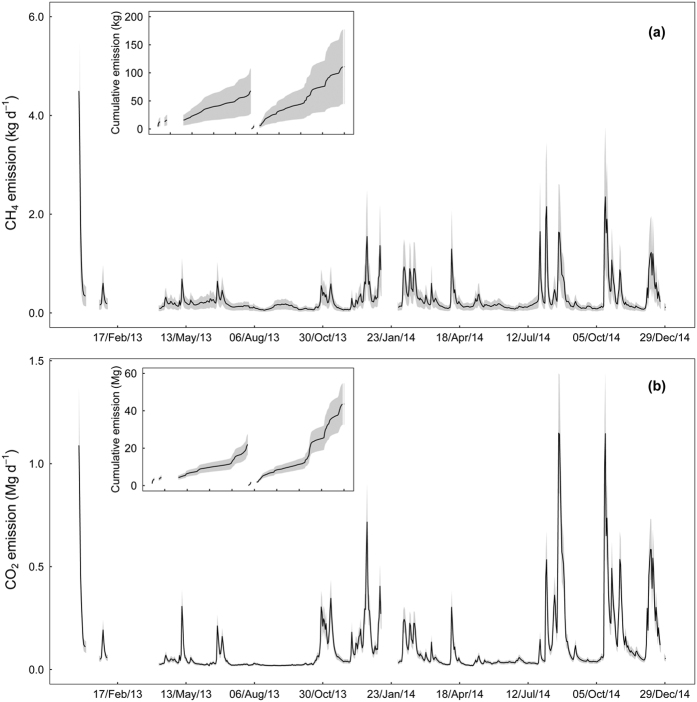
Daily emissions of CH4 (a) CO2 (b) from the studied streams in the two years. The inset panels in (a,b) shows the cumulative emissions of the two gases for the corresponding period. The shaded region represents an assumed uncertainty of ±60 and 25% of mean for CH4 and CO2 emissions, respectively (see Methods for details).